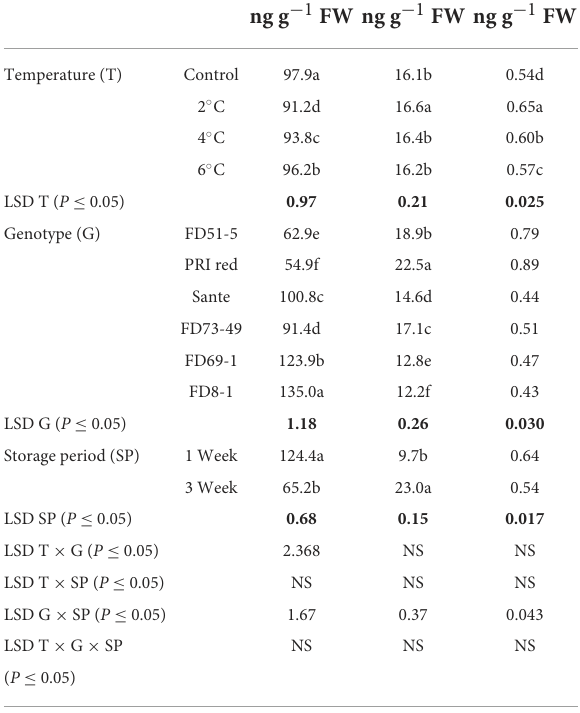
TABLE 4B Periodic changes in the contents of ABA, ZT, and GA 1 in experimental tubers of six potato genotypes following treatment with low-temperature cold storage during